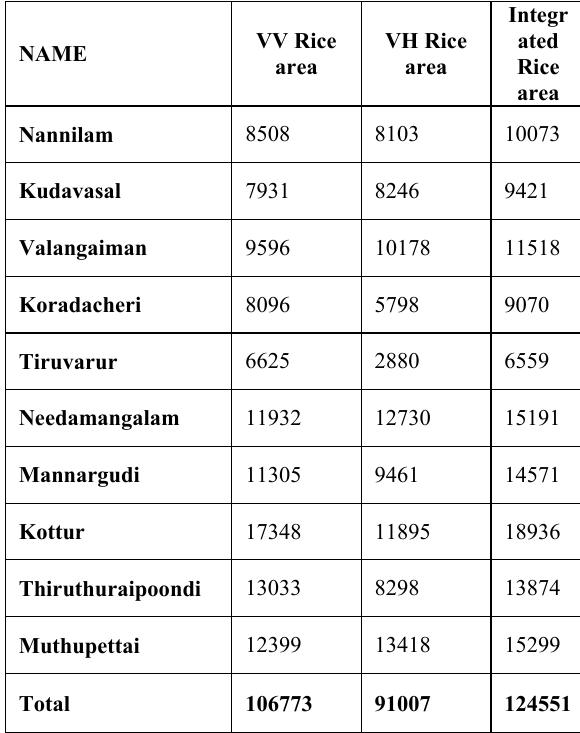
Fig.7 Rice Area Map of Integrated VV-VH Polarization